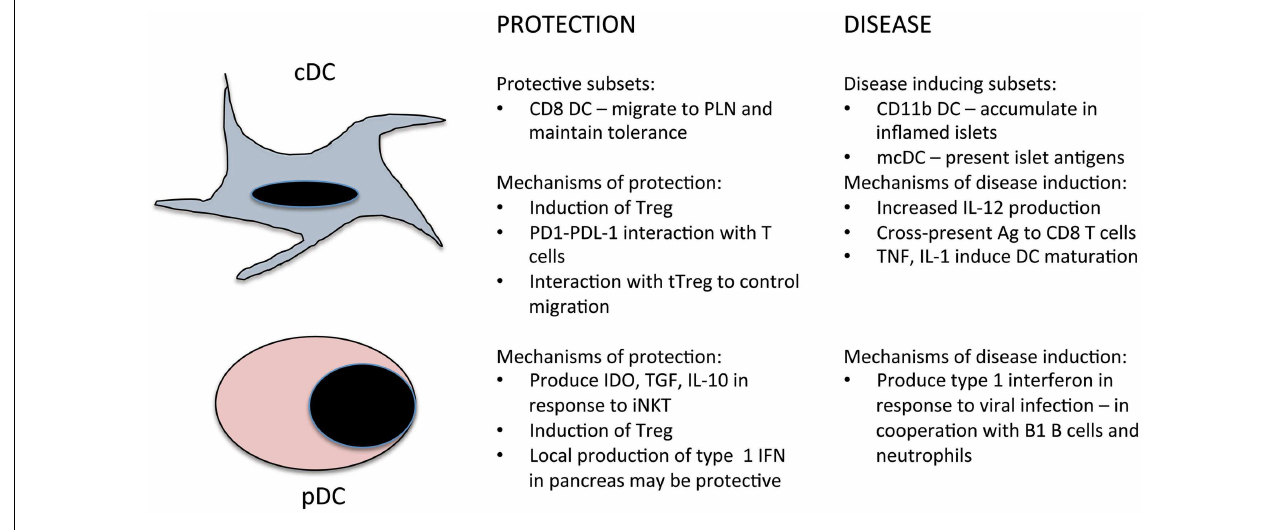
FIGURE 1 | Summary of the roles of cDC and pDC in the prevention and induction ofT1D